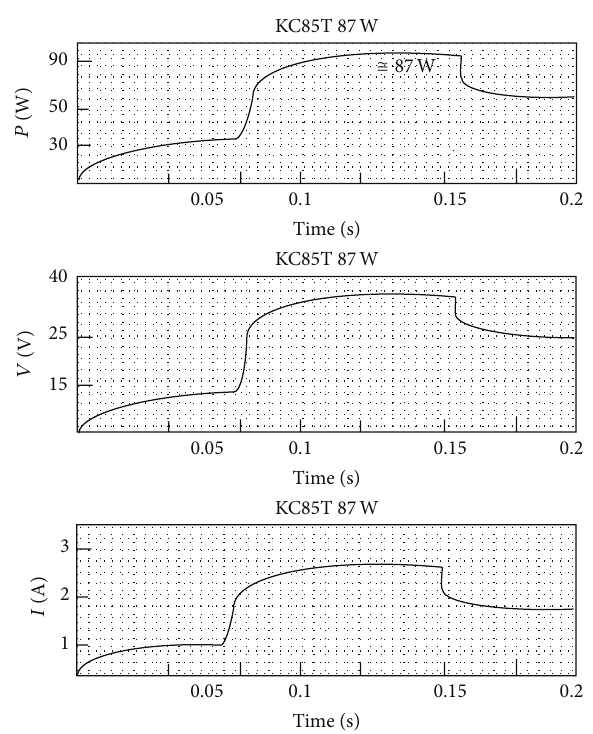
Figure 23: Tracking of maximum power, voltage, and current with respect to different irradiations for KC85T 87